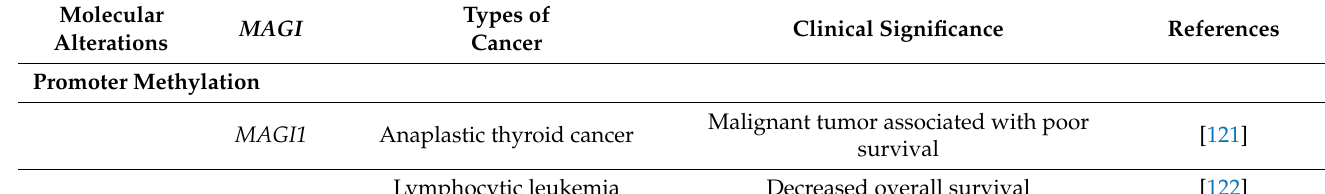
Table 2. MAGI genetic alterations, silencing, posttranscriptional modifications in